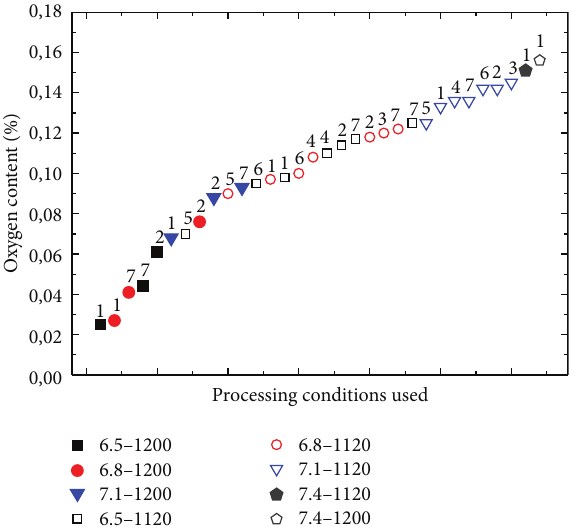
Figure 16: Fracture strength in relation to oxygen content achieved at processing condition